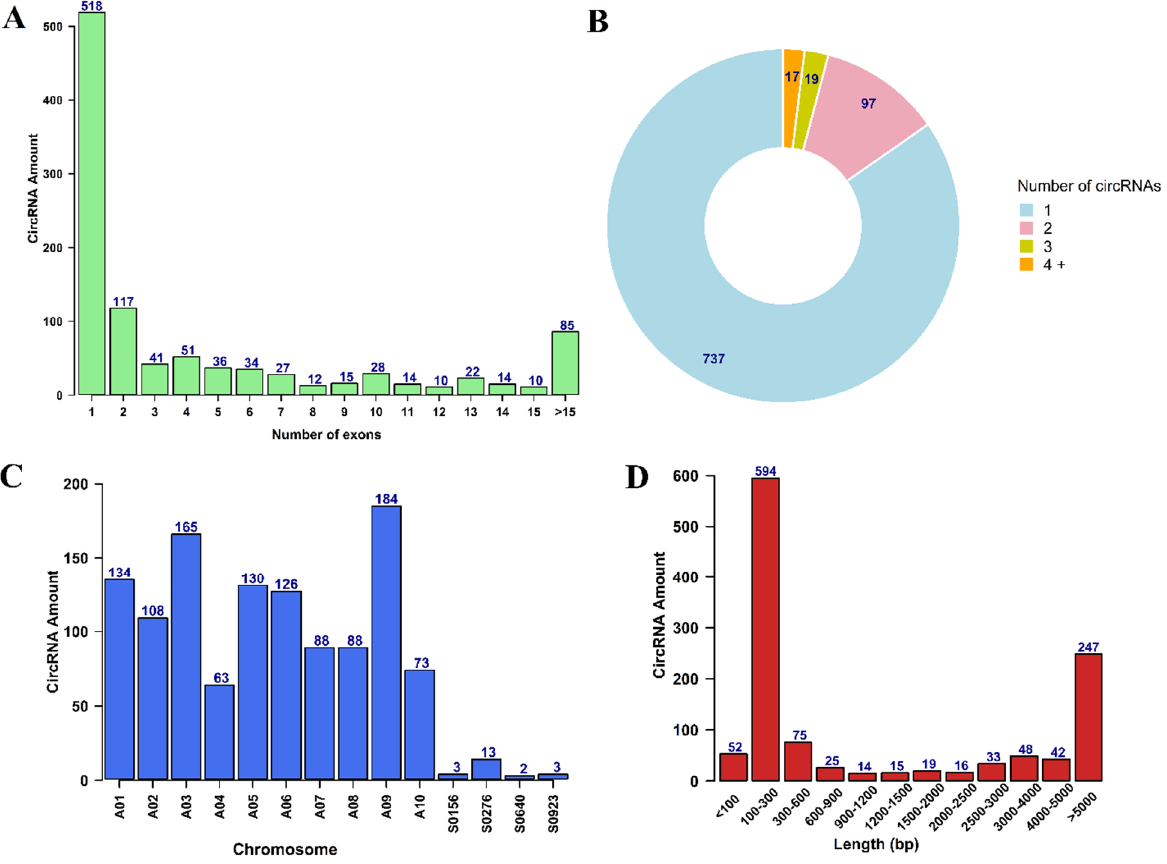
Figure 2. Genomic features of identified circRNAs during pollen development in B. rapa . ( A ) Distribution of the exon number per detected circRNA. ( B ) Distribution of the number of circRNA reads generated from the same parental gene. ( C ) The number of circRNAs detected in each chromosome. ( D ) Distribution of the length of circRNAs.